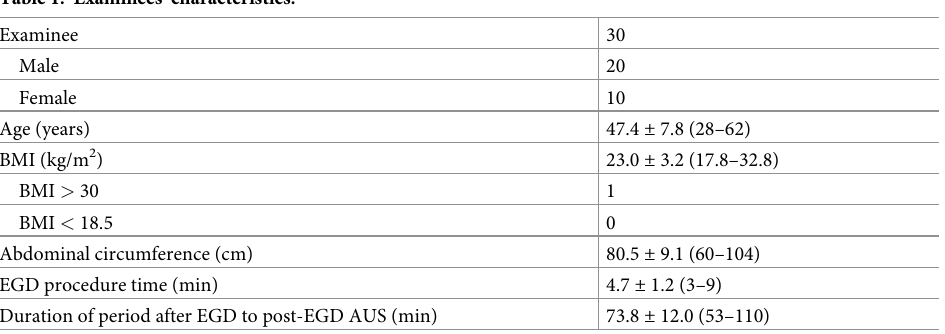
Table 1. Examinees’ characteristics.